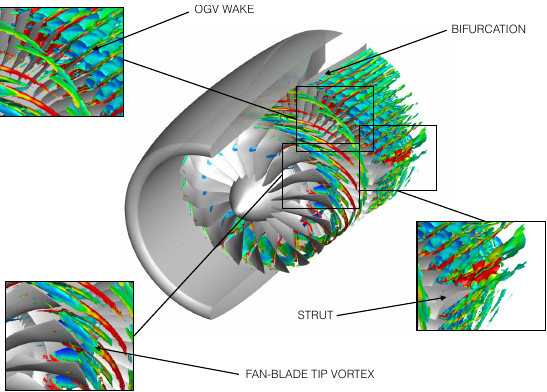
Figure 8. Isosurface of the Q-criterion colored by the vorticity modulus for the axisymmetric air-inlet